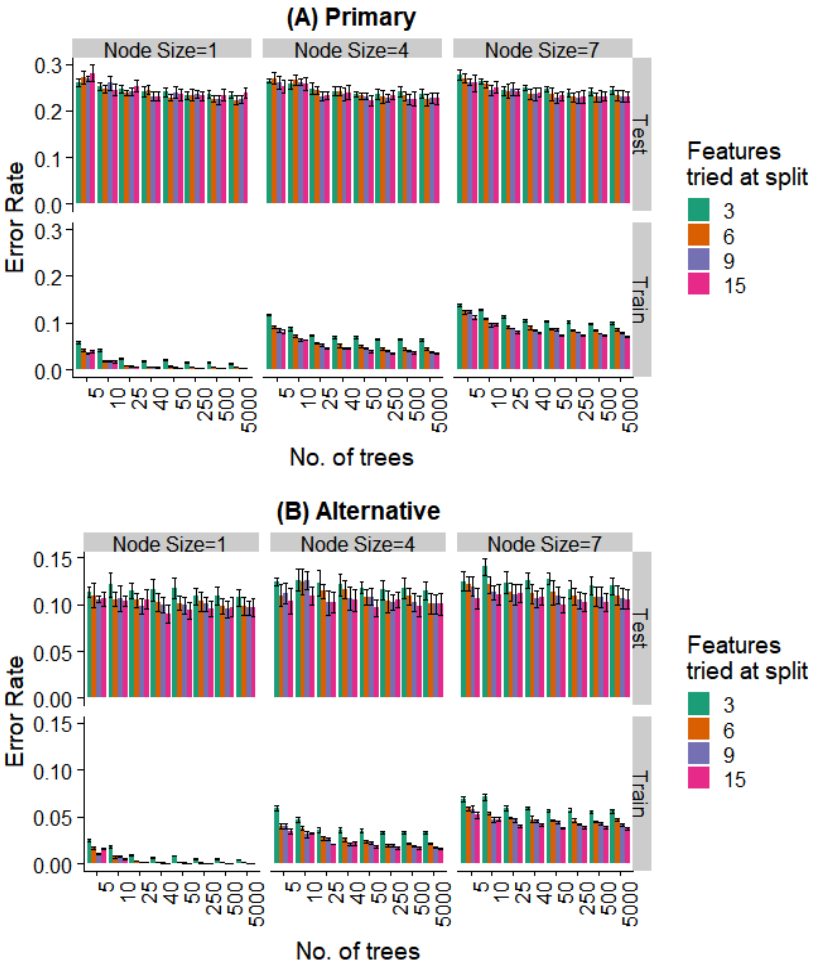
Figure 9. Effect of various training parameters on the random forest model for the binary prediction problem. The minimum node size, features tried at every level of split, and the number of trees are varied and the error rates for the training and test split are plotted. In ( A ), a prediction is considered an error if it does not agree with the expert’s primary diagnosis, and in ( B ), it is considered an error if the prediction does not agree with the primary or alternative diagnosis.